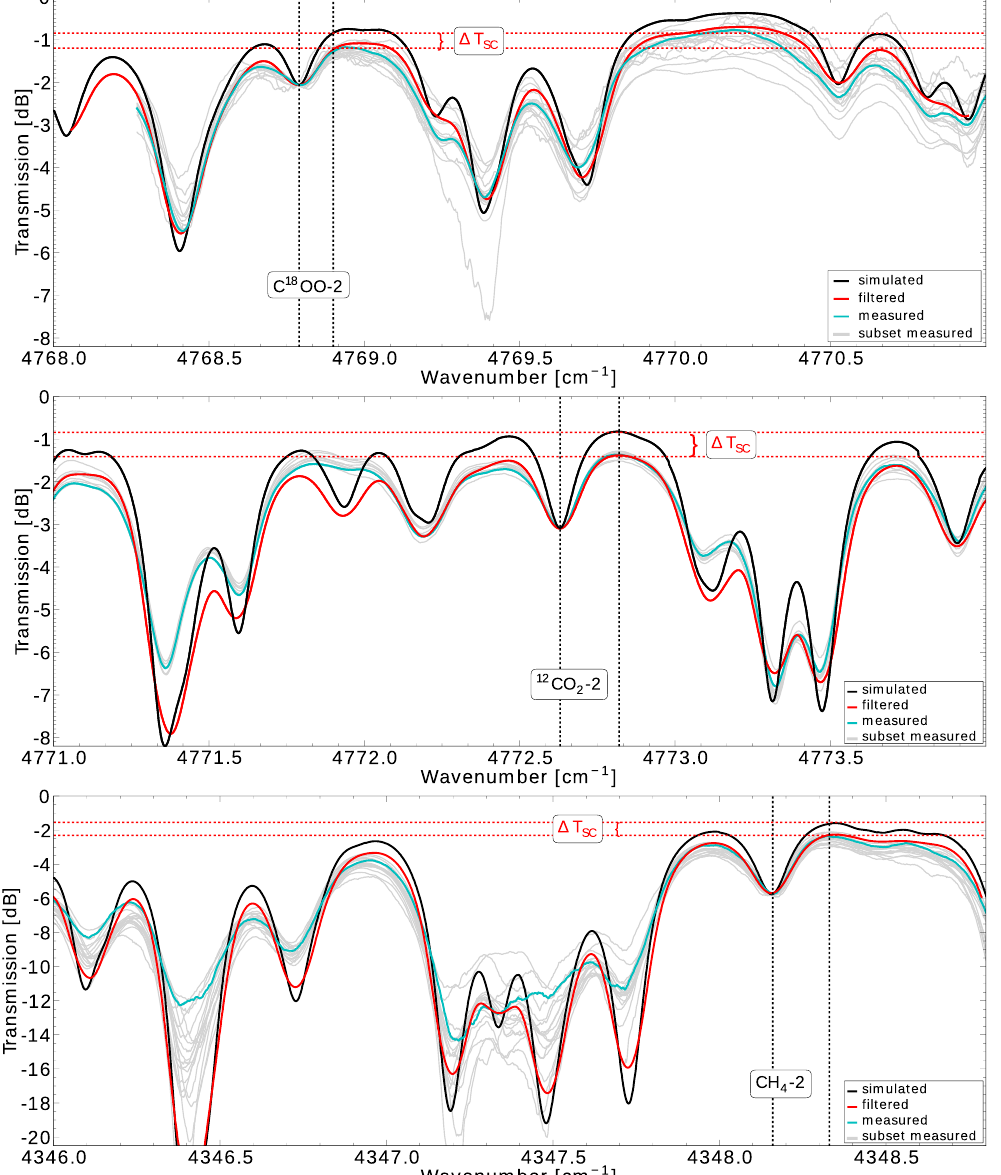
Figure 5. Examples of simulated spectra (black), filtered–simulated spectra (red), and measured spectra (cyan) from a typical set of measured spectra (gray), illustrating the spectral broadening, are aligned and marked in the same way as in Fig. 4. The wave number ranges illustrated in the three panels are the same as in Fig. 4, and the absorption lines illustrating the spectral broadening correction are marked in the same way as in Fig. 4. (cid:49) T SC marks the increment of differential transmission that is missing due to the line broadening in the measured data and that is therefore to be corrected for. The bundle of measured spectra shown in gray illustrates that any correction term (cid:49) T SC will also bring in some added